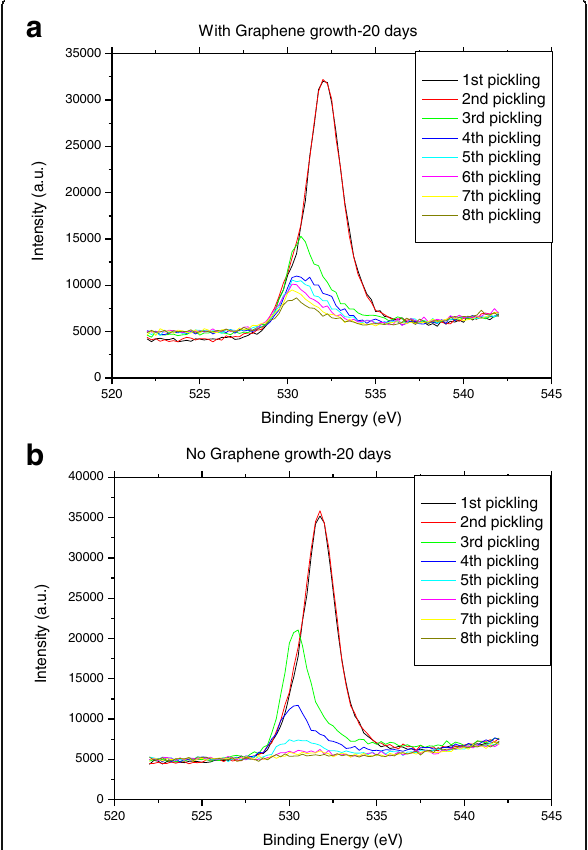
Fig. 3 XPS characterization. Detailed legend: XPS curves with the O1s spectrum for the polycrystalline copper surface measured after various consecutive annealing processes a with graphene grown on top and b without graphene grown on top